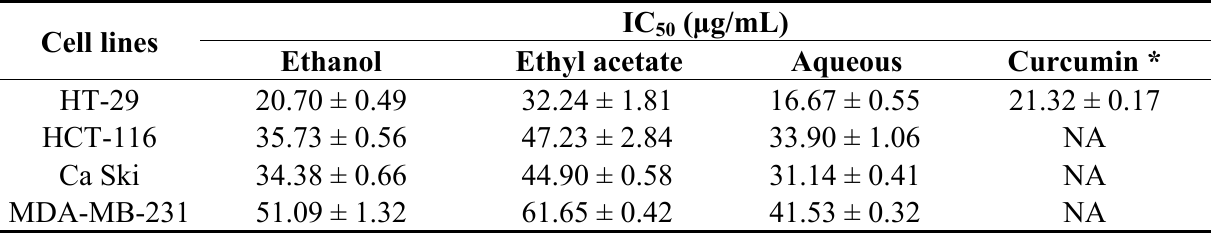
The data represent mean ± S.E. of three independent experiments (n = 9). NA: Not